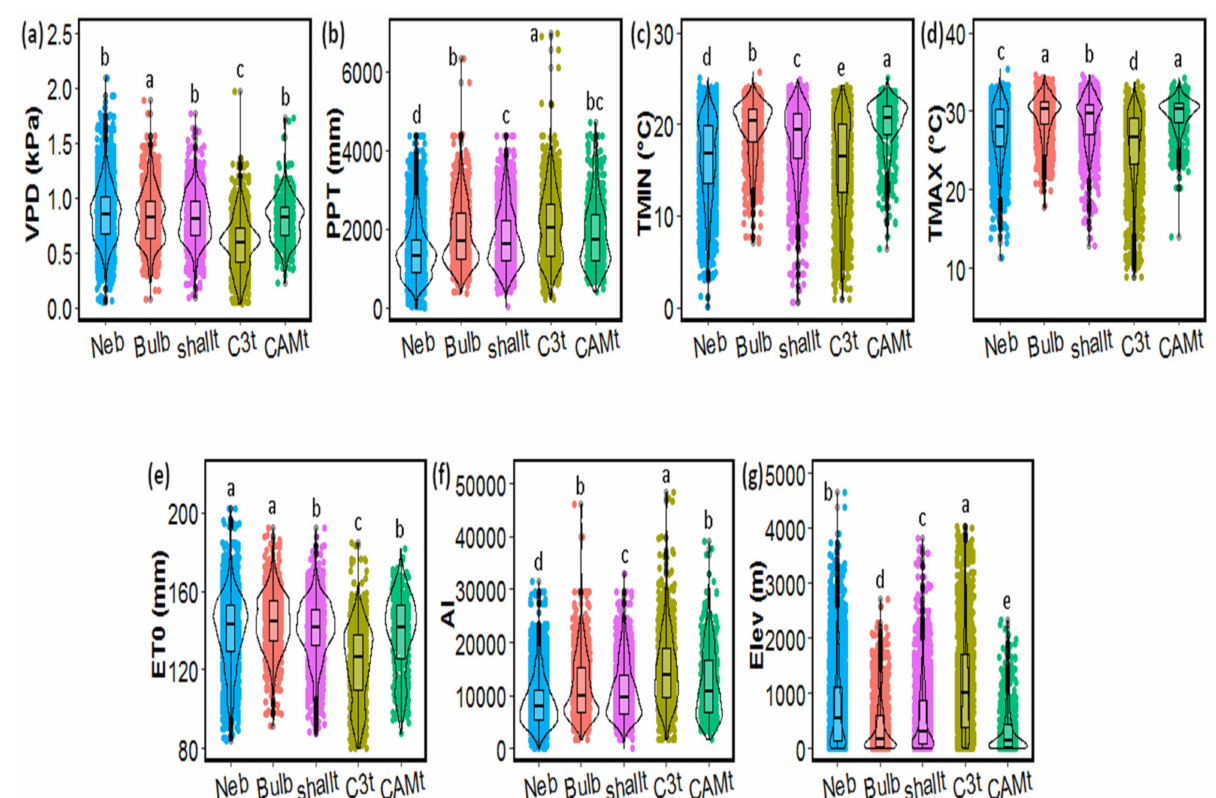
Figure 7. Comparison of environmental variables defining the average distribution area of the five functional groups of epiphytic Bromeliaceae, depicting environmental raw data. ( a ) VPD = vapor pressure deficit; ( b ) PPT = precipitation; ( c ) TMIN = minimum temperature; ( d ) TMAX = maximum temperature; ( e ) ET0 = evapotranspiration; ( f ) AI = aridity index; and ( g ) Elev = elevation per functional group. Neb = nebulophytes, Bulb = pseudobulbs, ShallT = shallow tank, C3T = C 3 tanks, and CAMT = CAM tanks. Groups with different letters are significantly different (Wilcoxon post-hoc test, p <